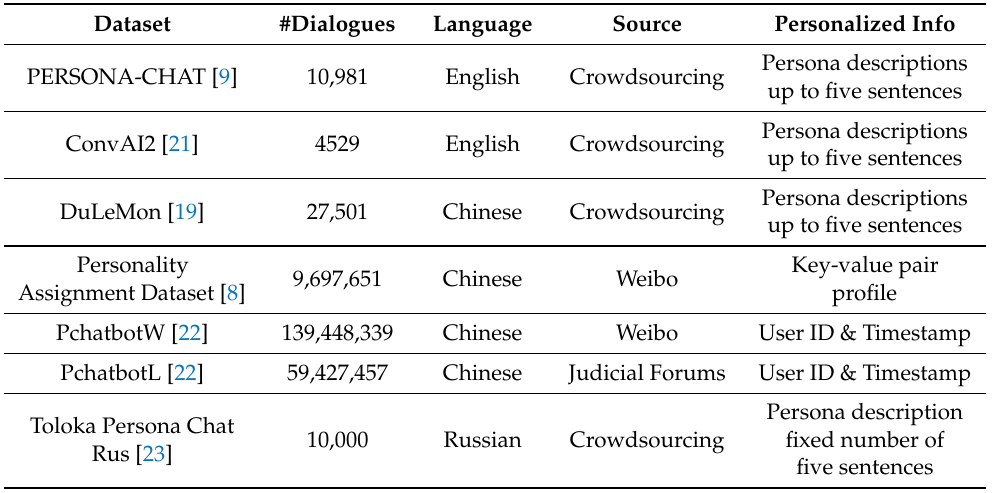
Table 1. Comparison of available datasets for building personalized dialogue